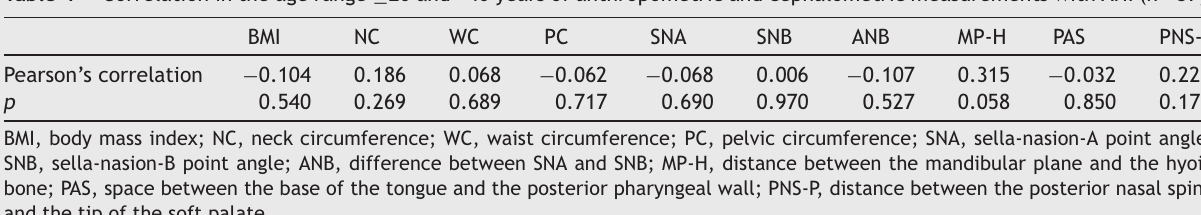
Correlation in the age range ≥ 20 and <40 years of anthropometric and cephalometric measurements with AHI ( n =